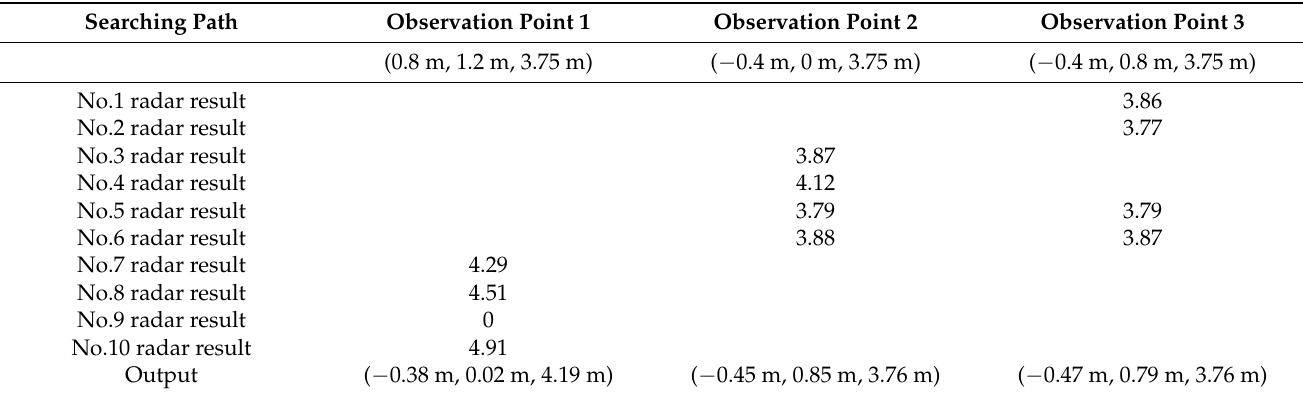
Figure 9. The experimental result of searching for a trapped person along a searching path. Table 3. The experimental result for the vital sign searching path.